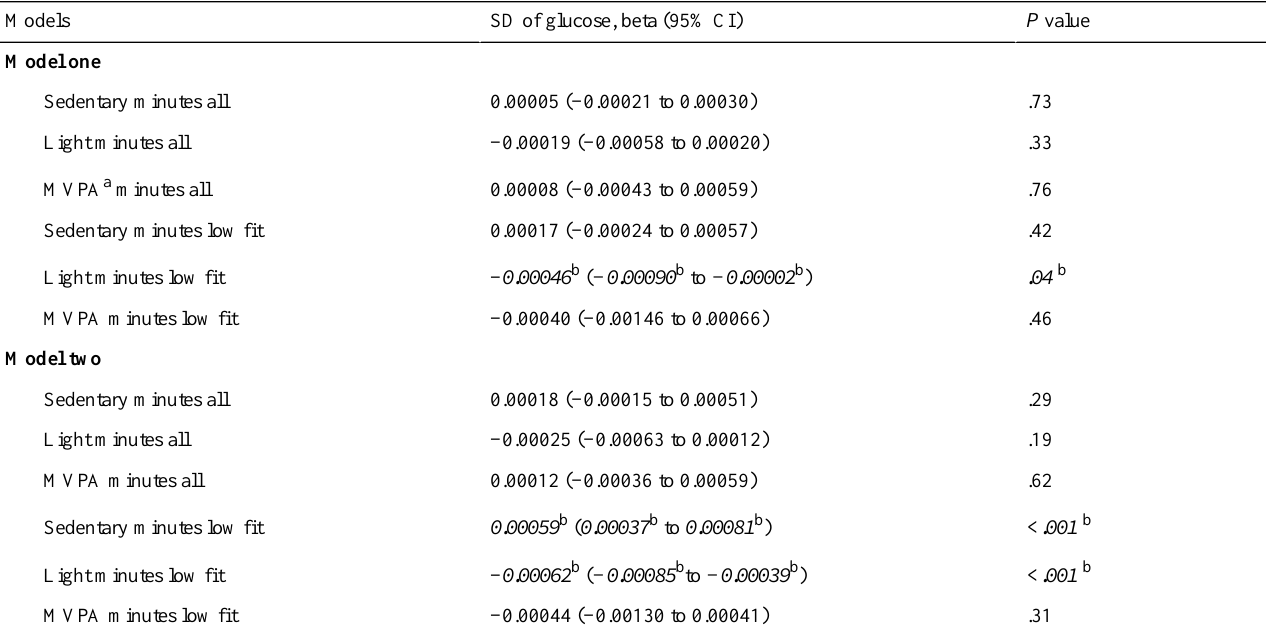
Table 4. Associations between physical activity and SD of glucose for the whole sample and for the low fitness group. Model one represents a univariable association, and model two is adjusted for wear minutes, age, sex, and percentage body